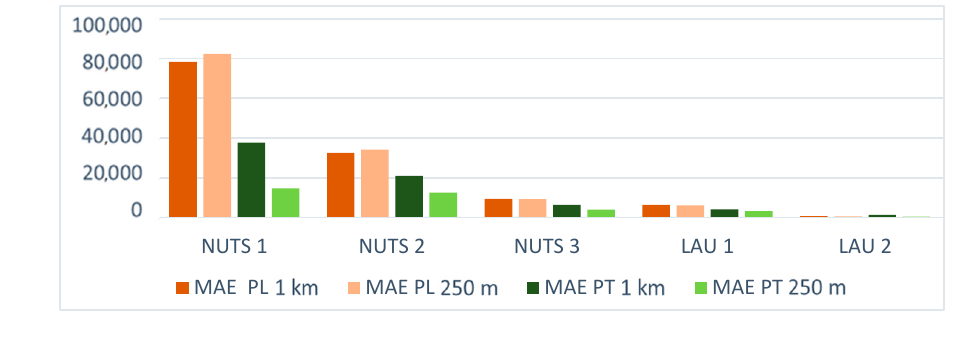
Figure 5. MAE in Poland and Portugal.